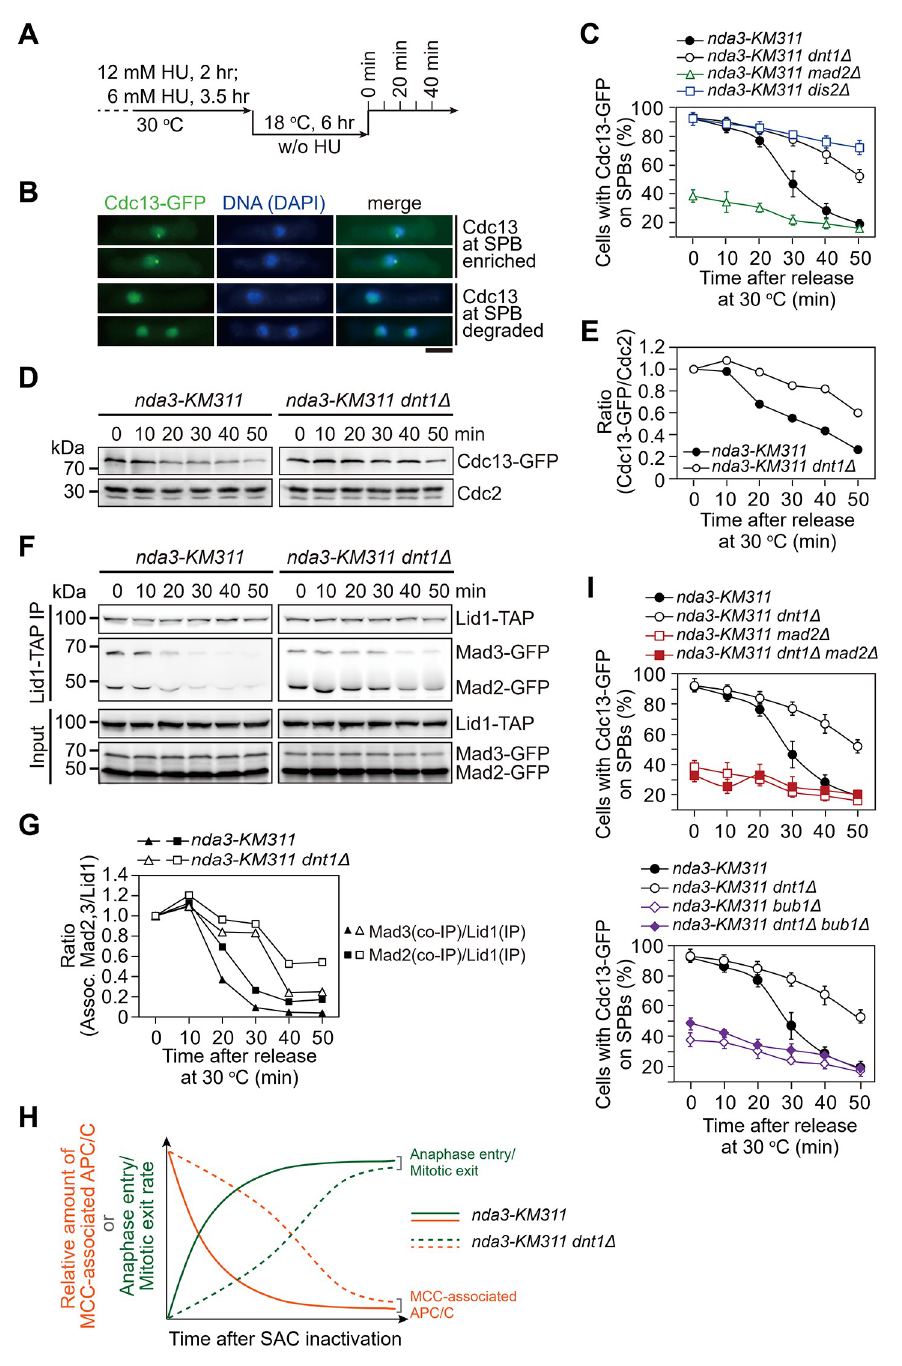
Fig 2. Dnt1 facilitates timely degradation of Cyclin B and dissociation of Mad2 and Mad3 from APC/C complex upon SAC inactivation. ( A ) Schematic depiction of the experiment design for ( B-G and I ). ( B-E ) Dnt1 is required for timely degradation of Cyclin B upon SAC inactivation. Example pictures of cells with Cdc13-GFP signals enriched or disappeared at spindle pole bodies (SPBs) are shown in ( B ). The percentage of cells with Cdc13-GFP on SPBs was assessed at each time point after shift to 30˚C ( C ), which served as an indicator for mitotic exit. Total protein levels of Cdc13-GFP were detected by Western blotting ( D ) and normalized to those of total Cdc2 at each time point, with the relative ratio between Cdc13-GFP and Cdc2 at 0 min set as 1.0 ( E ). Scale bar, 5 μ m. ( F-G ) Dissociation of the